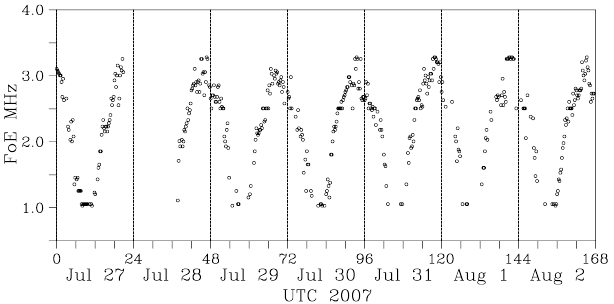
Fig. 2. FoE for the week of the E region FAI experiments measured by the HAARP